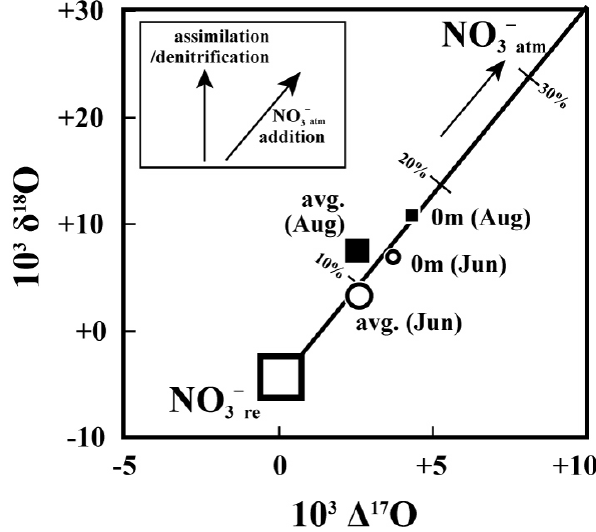
Fig. 7. Relationship between the values of 1 17 O avg and δ 18 O avg of NO − in the lake water (June: large white circle, August: 3 total large black square), as well as those of NO − in the surface (0m) 3 water (June: small white circle, August: small black square). A hy- ) and pothetical mixing line between atmospheric nitrate (NO − 3 atm ) is shown, together with the mixing remineralized nitrate (NO − 3 re ratios of NO − on the line and the endmember value of NO − 3 atm 3 re (large white